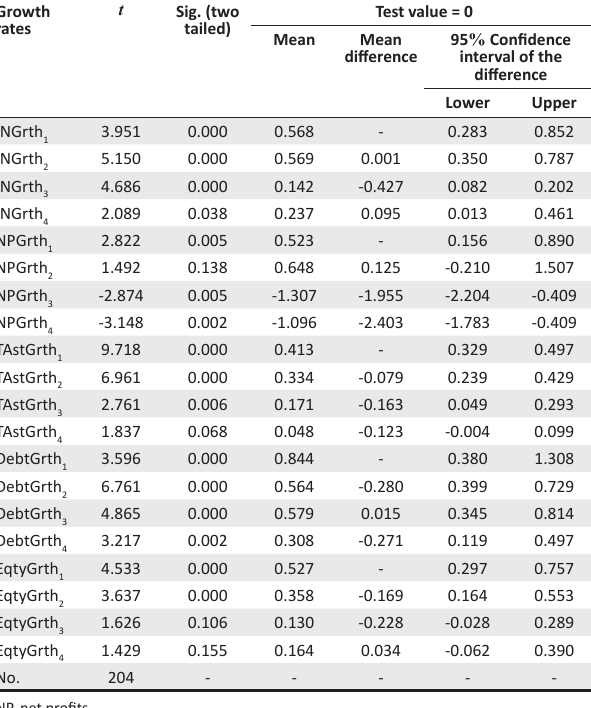
TABLE 4: Growth rate test of the IPO firms in 4 years after going public. Growth rates